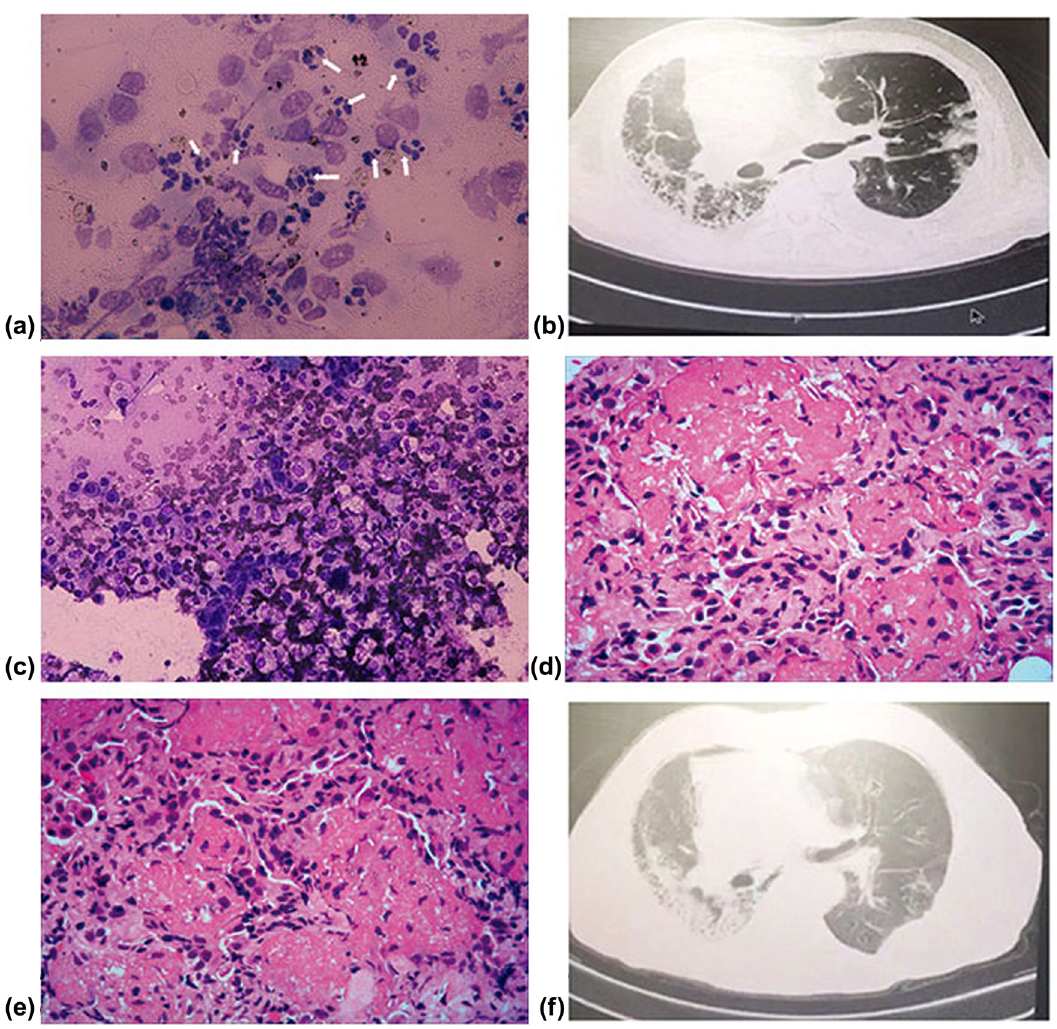
Figure 3: CT, ROSE, and histologic fi ndings of case 4 and